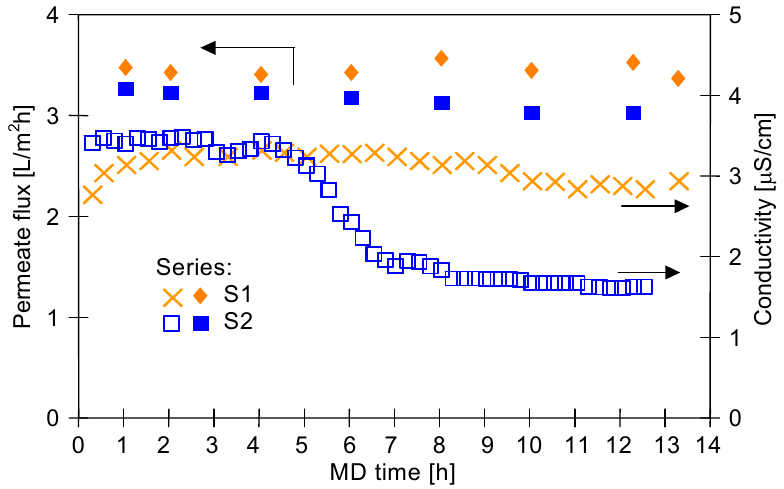
Figure 4. Changes in the permeate flux and distillate conductivity. Feed: Baltic Sea water (series S1), Baltic Sea water + oil (85 mg/L) + SDS (1.5 mg/L) (series S2). Module CMD.